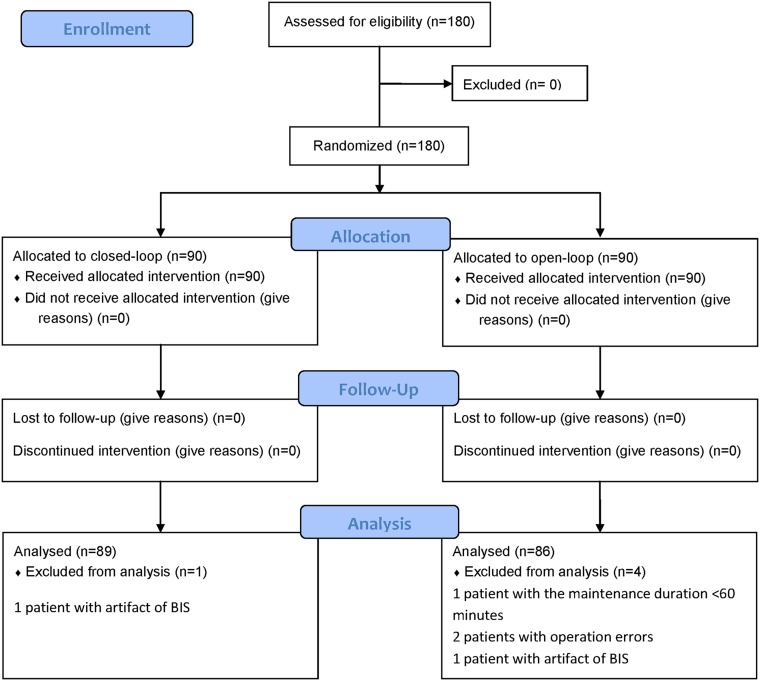
Patients’ flowchart.Of the 180 included patients, 1 and 3 patients were excluded from the closed-loop and opened-loop group, respectively, due to artifact of BIS, too short maintenance duration, or operation error. Thus, 89 and 86 patients were available for analysis in the two groups, respectively.